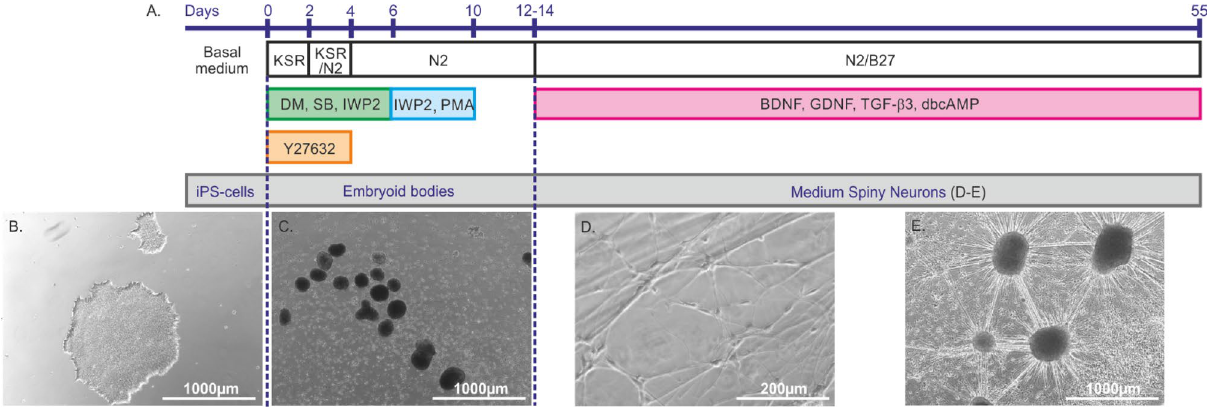
Figure 1. Schematic representation of the Stanslowsky protocol. ( A ) Timeline of the differentiation protocol. DM, SB and IWP2 induce the neural pathway driving the formation of embryoid bodies. IWP2 associated with PMA induces the regional patterning towards the subpallium that comprises large parts of the basal ganglia including striatum and globus pallidus. Y27632 inhibits apoptosis to prevent cell decline at the beginning of the differentiation. The neuronal growth factors BDNF, GDNF and TGF-β3 terminate the differentiation into MSNs and drive their maturation, while dbcAMP increases the intracellular Ca 2+ levels and contributes to the maturation process. ( B ) hiPS cells grow in basal medium until DIV0. DIV0 to DIV12-14 initiates the formation of embryoid bodies. ( C ) From DIV12-14 to DIV55 ± 3, the neurons are exposed to growth factors to